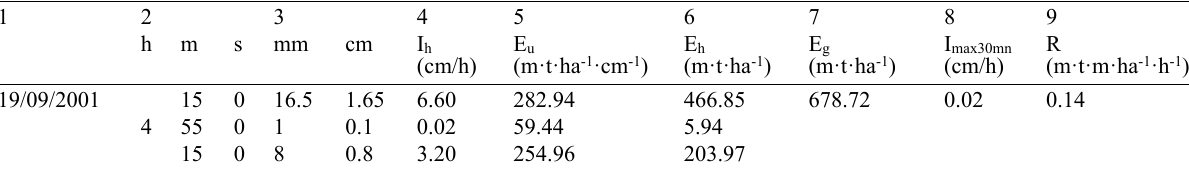
Fig. 4 Hyetograph reconstituted by storm of 19/09/2001. Table 2 Example of hyetograph analysis.